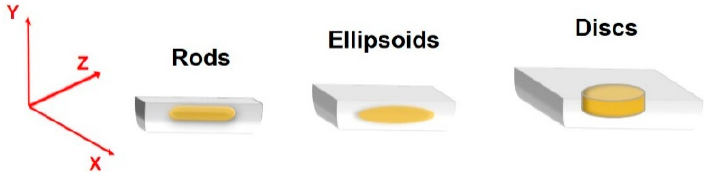
Figure 5. Schematic drawing of different types of non-spherical particles. Designing masks with different channel heights resulting in particles with different shapes, sizes and aspects ratios [123,124].